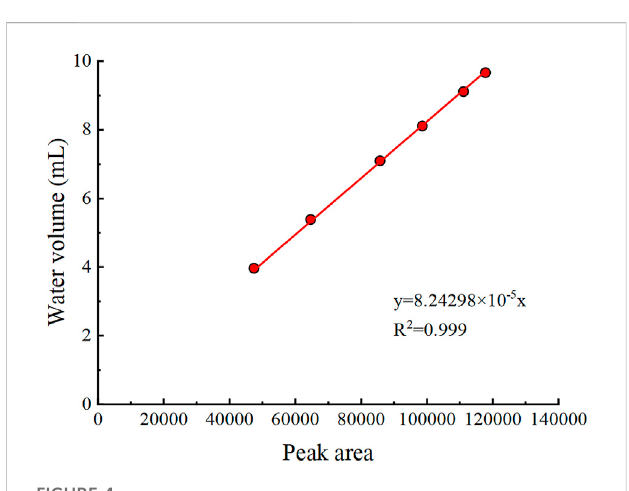
FIGURE 4 Standard curve between peak area and water volume. FIGURE 5